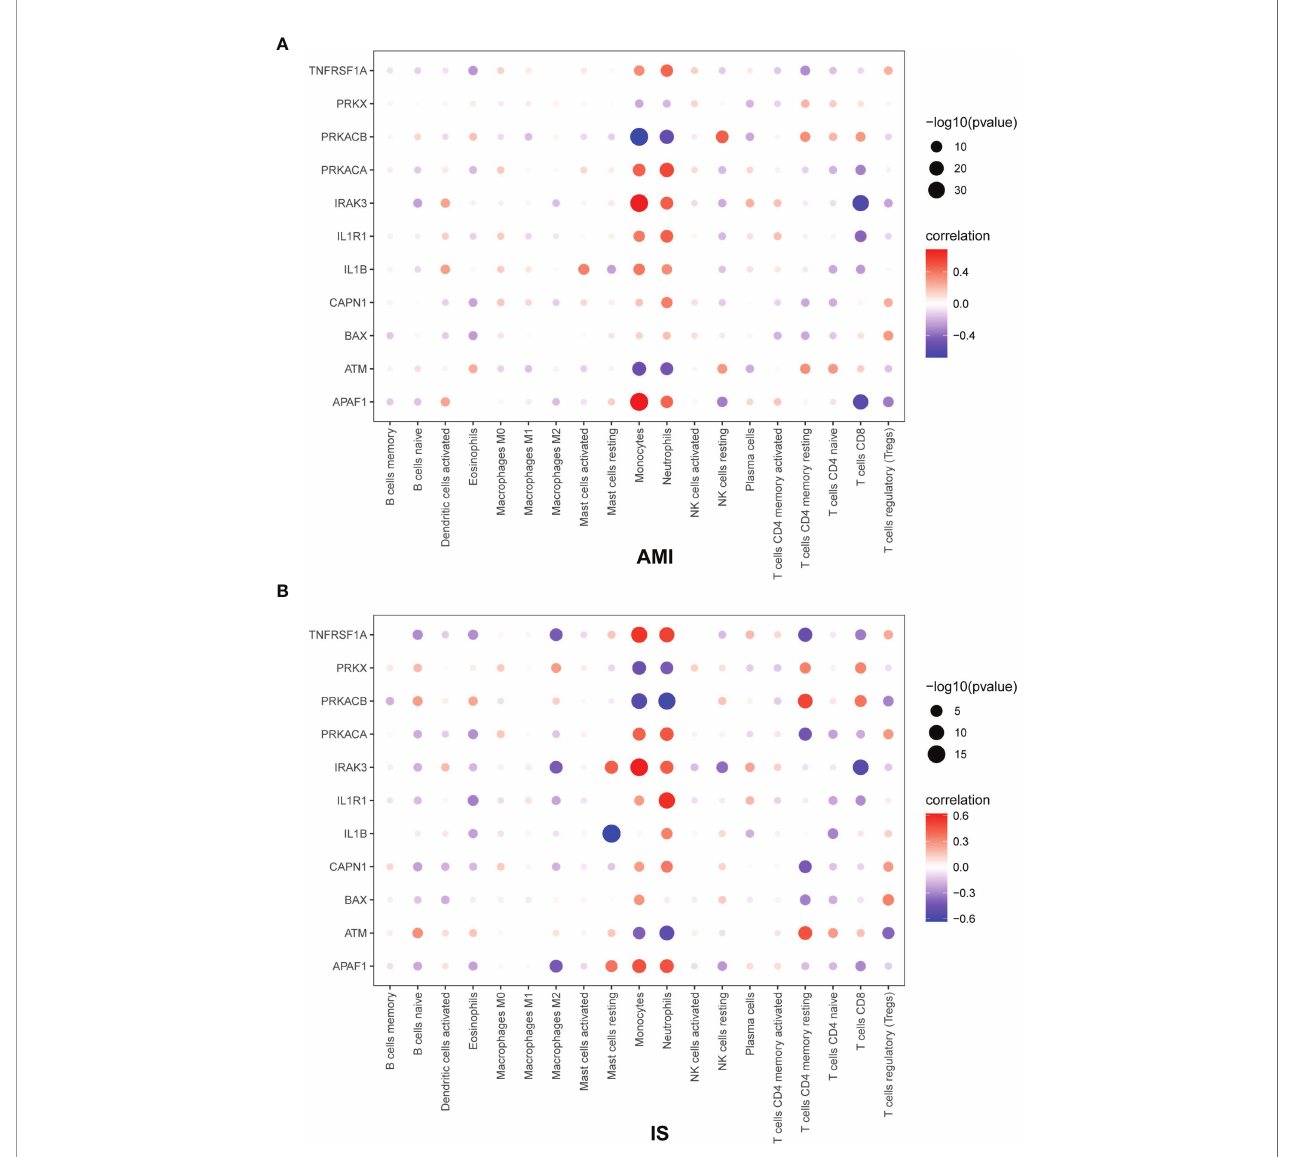
FIGURE 8 | Pearson correlation coef fi cient between immune cells and apoptosis-related genes in (A) AMI and (B) IS. The Pearson correlation coef fi cient was determined by Pearson correlation analysis and the P -values were calculated by t